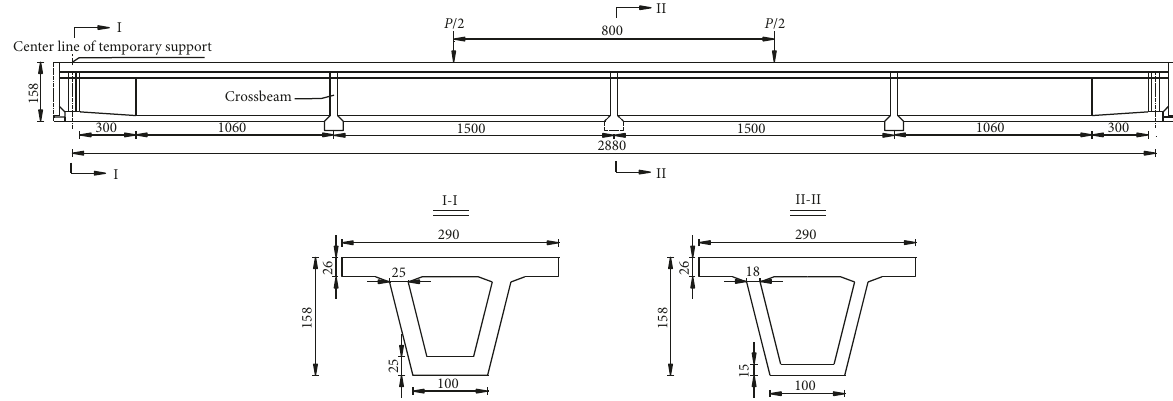
Figure 4: Test configuration of the girders (unit: cm).